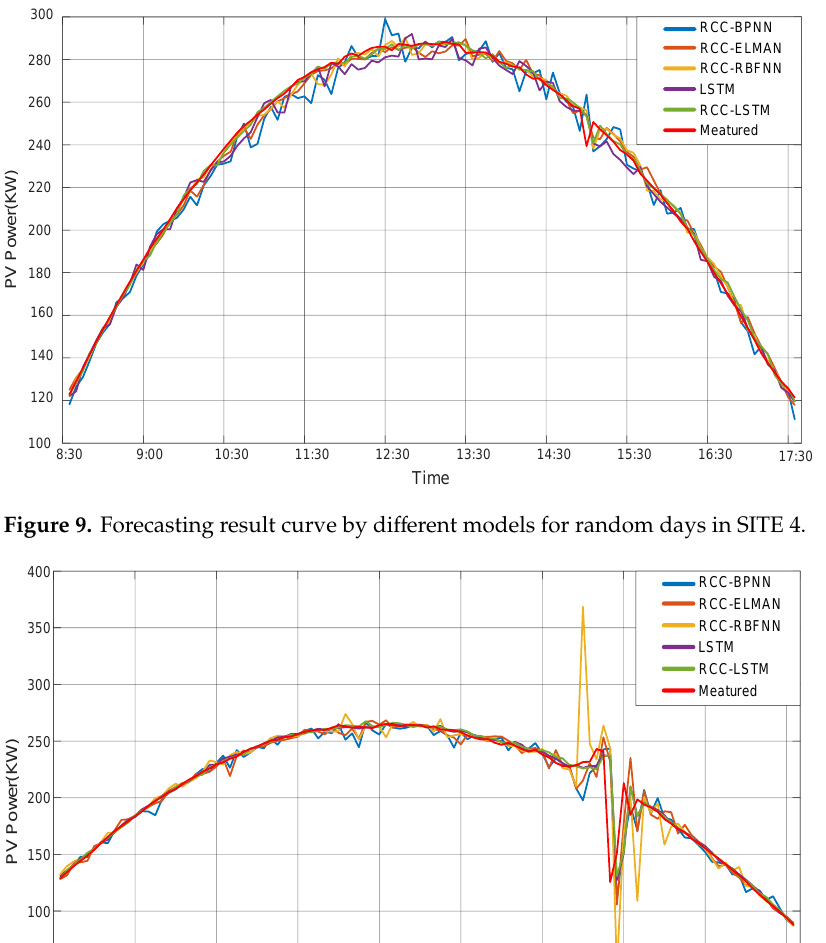
Figure 8. The implementation procedure of the proposed model.